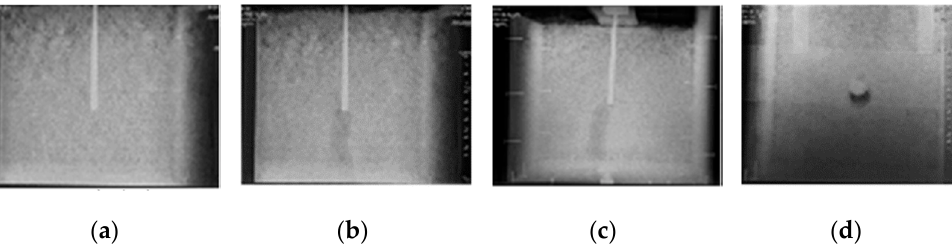
Figure 19. Images of modified soil with water content of 25%: ( a ) Before breakdown; ( b ) front view; ( c ) side view; ( d ) top view.